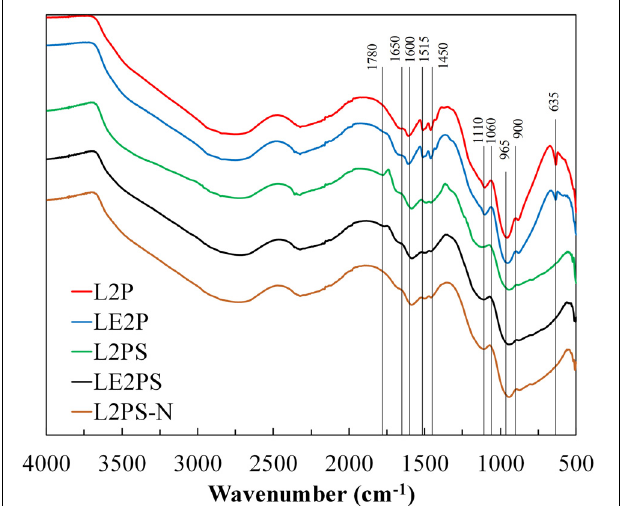
FIGURE 2 | FTIR spectra of the different H 3 PO 4 -lignin derived samples.